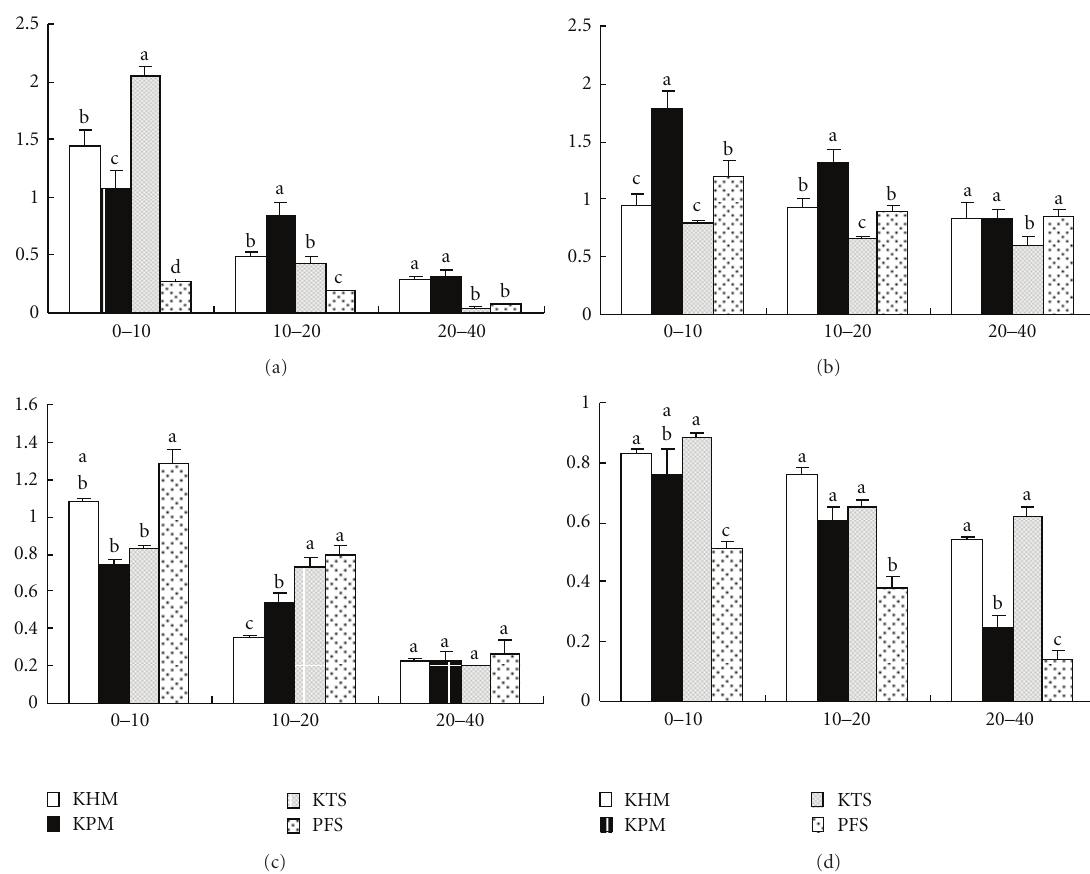
Figure 1: Soil enzyme activities (per gram dry weight) from samples collected at di ff erent depths in the four meadow communities: (a) urease (mg NH 4 -N/g); (B) protease (mg Tyr/g); (c) alkali phosphatase (mg phenol/g); (d) invertase (mg glucose/g). Bars indicate standard deviation ( n = 6). At the same depth for di ff erent communities, values with the same letters are not significantly di ff erent ( P ≤ . 05). Kobresia humilis meadow = KHM; Kobresia pygmaea meadow = KPM ; Kobresia tibetica swamp meadow = KTS ; Potentilla fruticosa scrub = PFS